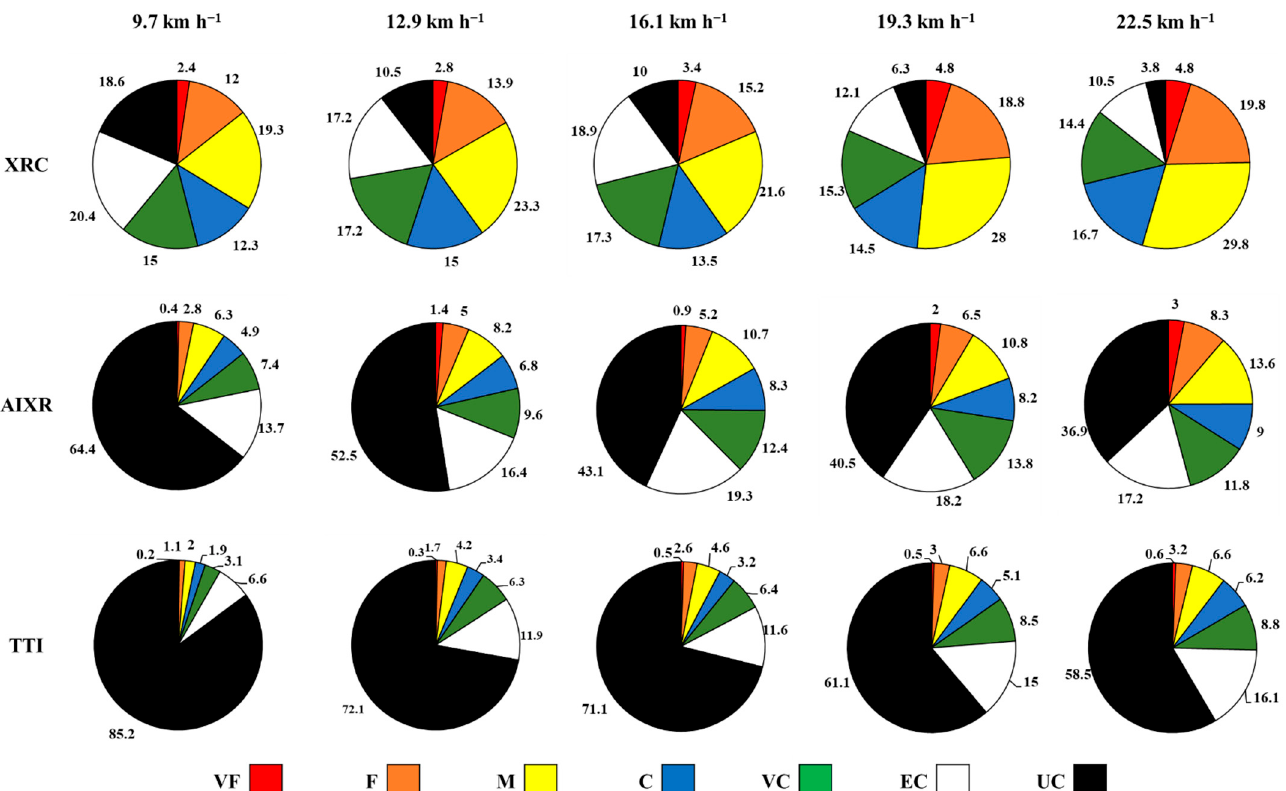
Figure 5. Spray quality (droplet size classification based on volume median diameter) for XRC, AIXR, and TTI nozzles at varying ground speeds for SRC. SRC represents the sprayer equipped with a rate controller while XRC, AIXR, and TTI represent TeeJet ® extended range, air induction extended range, and turbo-teejet induction nozzle type, respectively, used in this study. VF, F, M, C, VC, EC, and UC represents the very fine, fine, medium, coarse, very coarse, extremely coarse, and ultra-coarse spray droplets, respectively, as defined by the ASABE S572.3 [16].